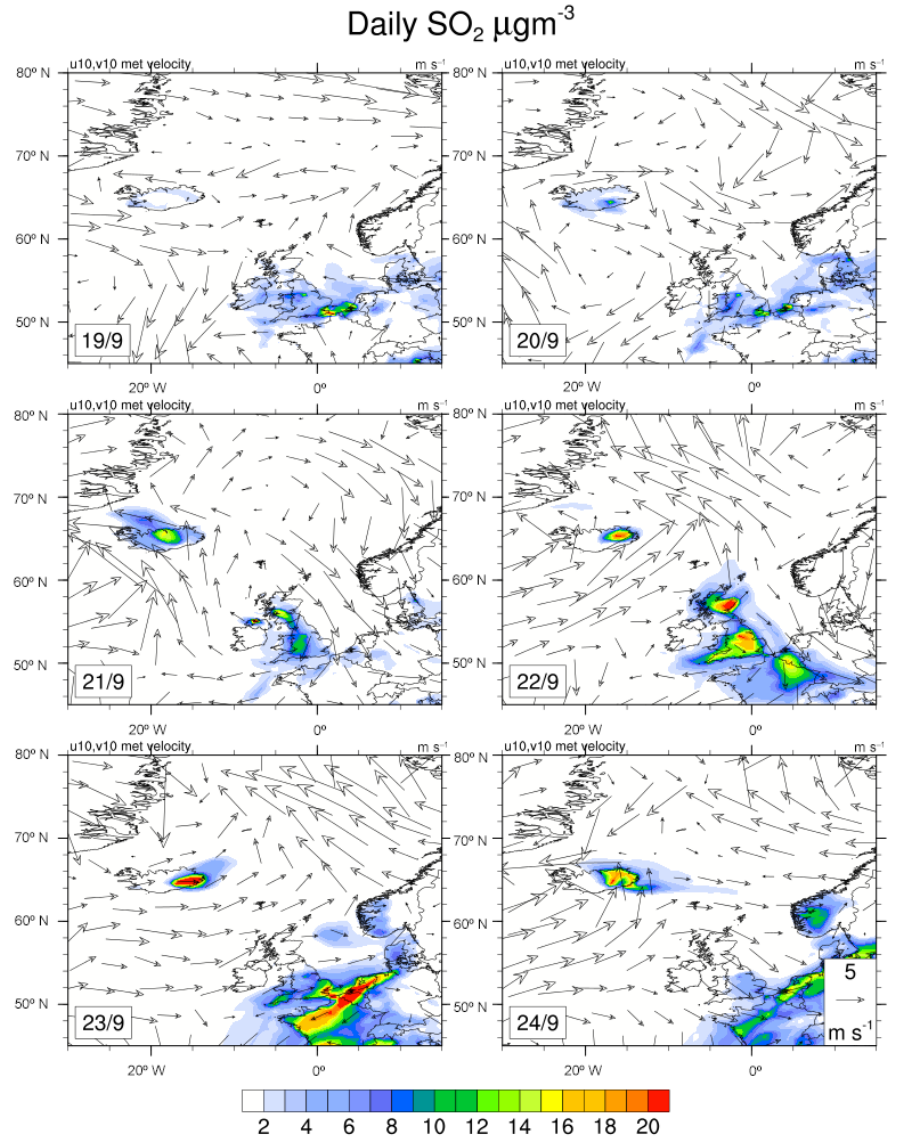
Figure 4. Daily average surface concentration (µgm − 3 ) of SO 2 from 19 to 24 September 2014, calculated by the EMEP4UK model and the 12:00GMT of each day’s wind